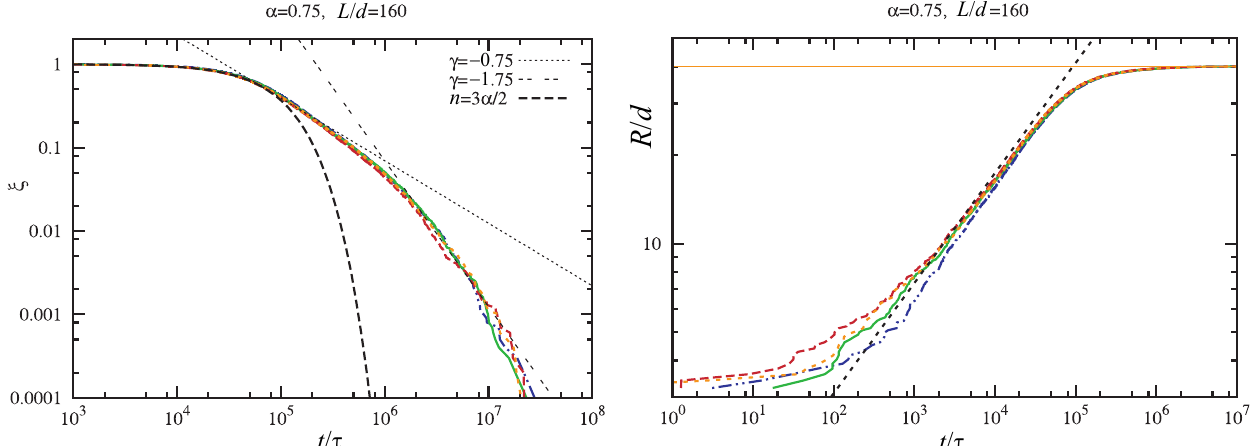
Figure 2. Time dependencies of supersaturation degree and precipitate radius in the fractional Ham model (with the Riemann–Liouville operator), α = 0.75. Various colors of kinetic curves correspond to different realizations of the